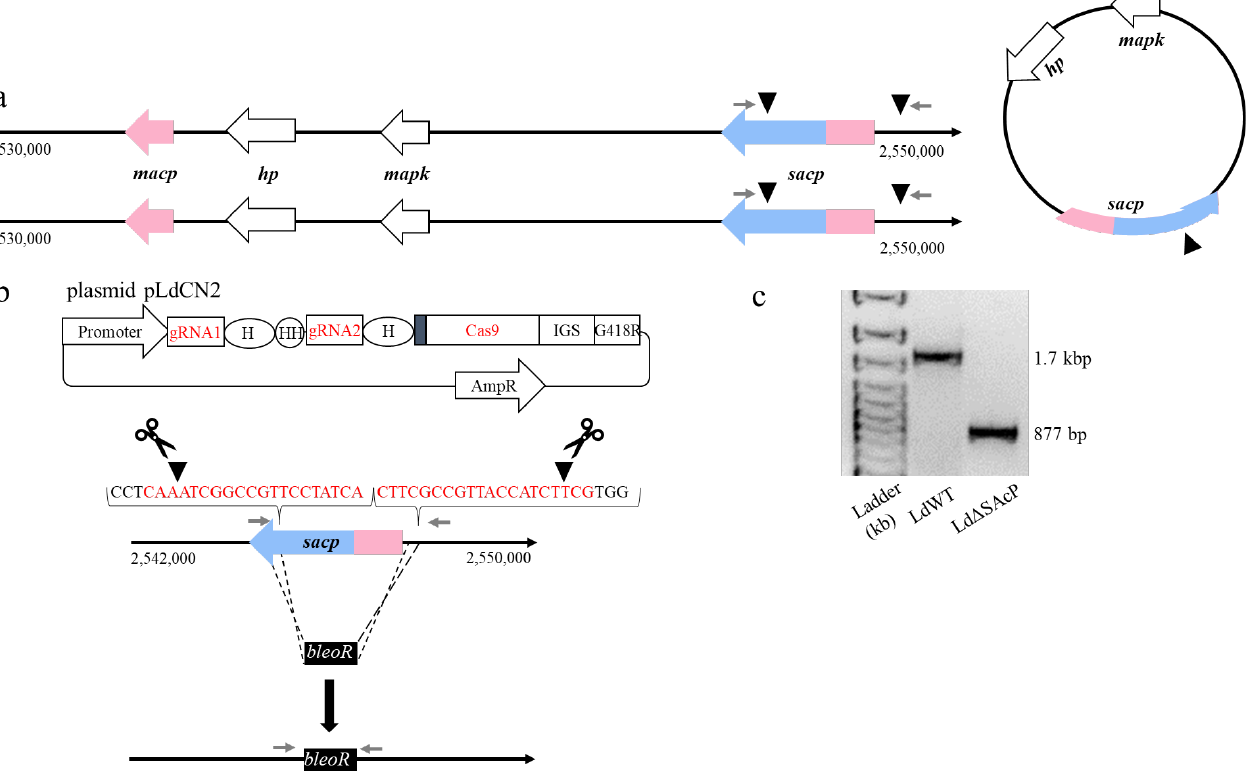
Figure 2. Generation of the L. donovani mutant, Ld ∆ SAcP, using CRISPR-Cas9 gene editing. ( a ) Ge- netic representation of the sacp loci. The usually diploid chromosome 36 is illustrated from position 2,530,000 to position 2,550,000 containing the macp gene (LdCL_360075700) in pink, the hp gene (LdCL_360075800) in white, the mapk gene (LdCL_360075900) in white and the sacp gene (LdCL_360076000) in blue, with the homologous sequence to the macp gene in pink. The hp gene, the mapk gene and the sacp gene are also encoded on one episome. The black triangles indicate the locations of the Cas9 endonuclease cut sites and the grey arrows represent the primers used in PCR. ( b ) Gene editing strategy to remove sacp. Promastigotes were transfected with the CRISPR vector pLdCN2 [22] containing two guide RNAs specific to the sacp gene but not to the macp gene. The gRNA sequences are in red, and the PAM sequence is in black with the cut sites indicated by the black arrows. Promastigotes were subsequently transfected with a bleomycin resistance gene ( bleoR ), and through microhomology end joining, the bleoR gene is integrated into the sacp gene. ( c ) Gel-electrophoresis of the PCR analysis with the primers LdSAcPF2 and LdSAcPR (Table S1) of the sacp gene from LdWT DN A (1685 bp) and the LdΔSAcP DNA (877 bp). To determine whether the sacp gene-targeted mutants lost the expression of SAcP protein, a Western blot analysis was performed using a polyclonal antiserum previously shown to react against SAcP but not MAcP [10]. As shown in Figure 3a, SAcP was detected in the promastigote supernatant but not the pellet derived from wildtype L. donovani 1S2D as expected for a secreted enzyme. In contrast, there was no detectable SAcP in the super- natant derived from the LdΔSAcP mutant. Next, the promastigote’s ability to hydrolyze the phosphatase substrate 4-methylumbelliferyl phosphate (MUP) was compared as a measurement of acid phosphatase activity in logarithmic and stationary phases of pro- mastigote proliferation. As shown in Figure 3b, the acid phosphatase activity was lower in LdΔSAcP than in LdWT for the cell culture supernatant proteins but was the same in the pellet containing the parasite-bound proteins. Taken together, the PCR (Figure 2c), the Western blot (Figure 3a) and the enzyme activity assay (Figure 3b) data provide strong evidence that the sacp genes have been successfully deleted in the L. donovani LdΔSAcP mutant. We attempted to generate a sacp gene addback prior to undertaking phenotypic